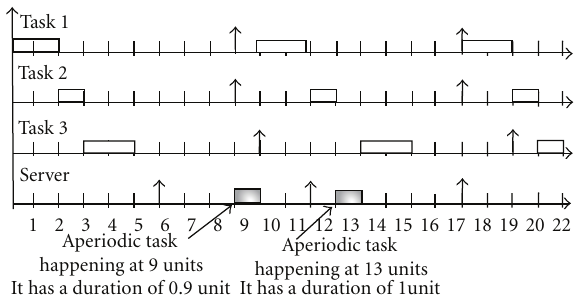
Figure 2: Task organization considering second example for